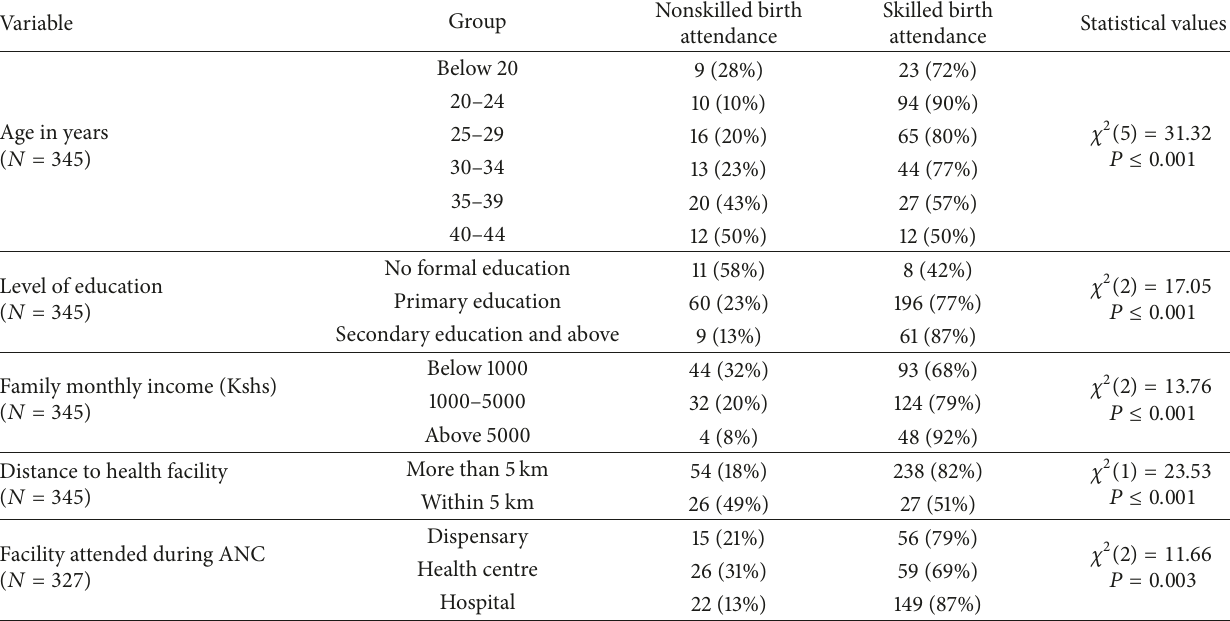
Table 1: Demographic and institutional factors associated with skilled birth attendance.